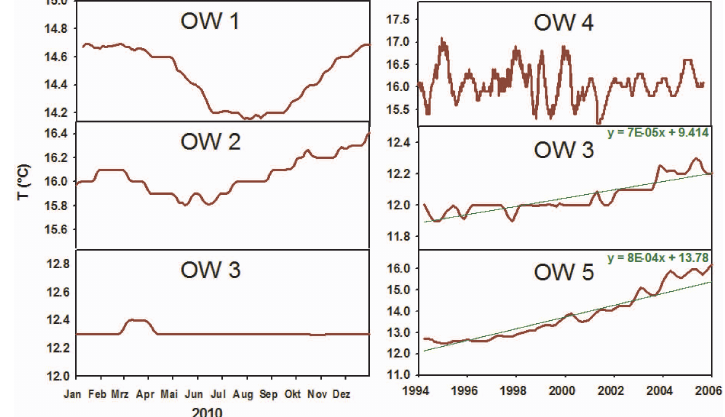
Fig. 4. Left panels: selected time series for the year 2010 illustrating the short-term and annual development of groundwater temperatures (note the different axis intercepts; see text for further explanation and for locations Fig. 1). Right panels: selected time series for the years 1994 to 2006 illustrating the long-term and seasonal development of groundwater temperatures (note the different axis intercepts; see text for further explanation and for locations Fig.